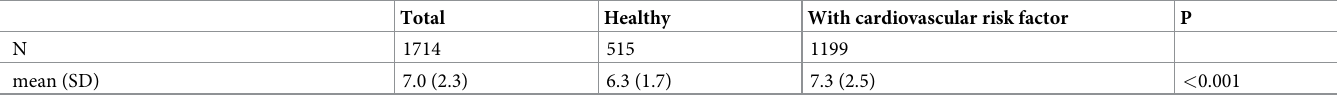
Values are given as mean ± standard deviation. P values refer to the comparison of healthy individuals versus individuals with cardiovascular risk factors. BP = blood pressure, HDL = high density lipoprotein, LDL = low density lipoprotein, HbA1c = hemoglobin A1c, GL-PSS = global longitudinal peak systolic strain, SR = strain rate, LVEDD = left ventricular end-diastolic diameter, IVSd = interventricular septum end-diastolic, LVPWd = left ventricular posterior wall end-diastolic, LA = left atrium, LVEF = left ventricular ejection fraction, e´ = PW-Doppler derived early diastolic myocardial lengthening velocity, E = early mitral inflow velocity